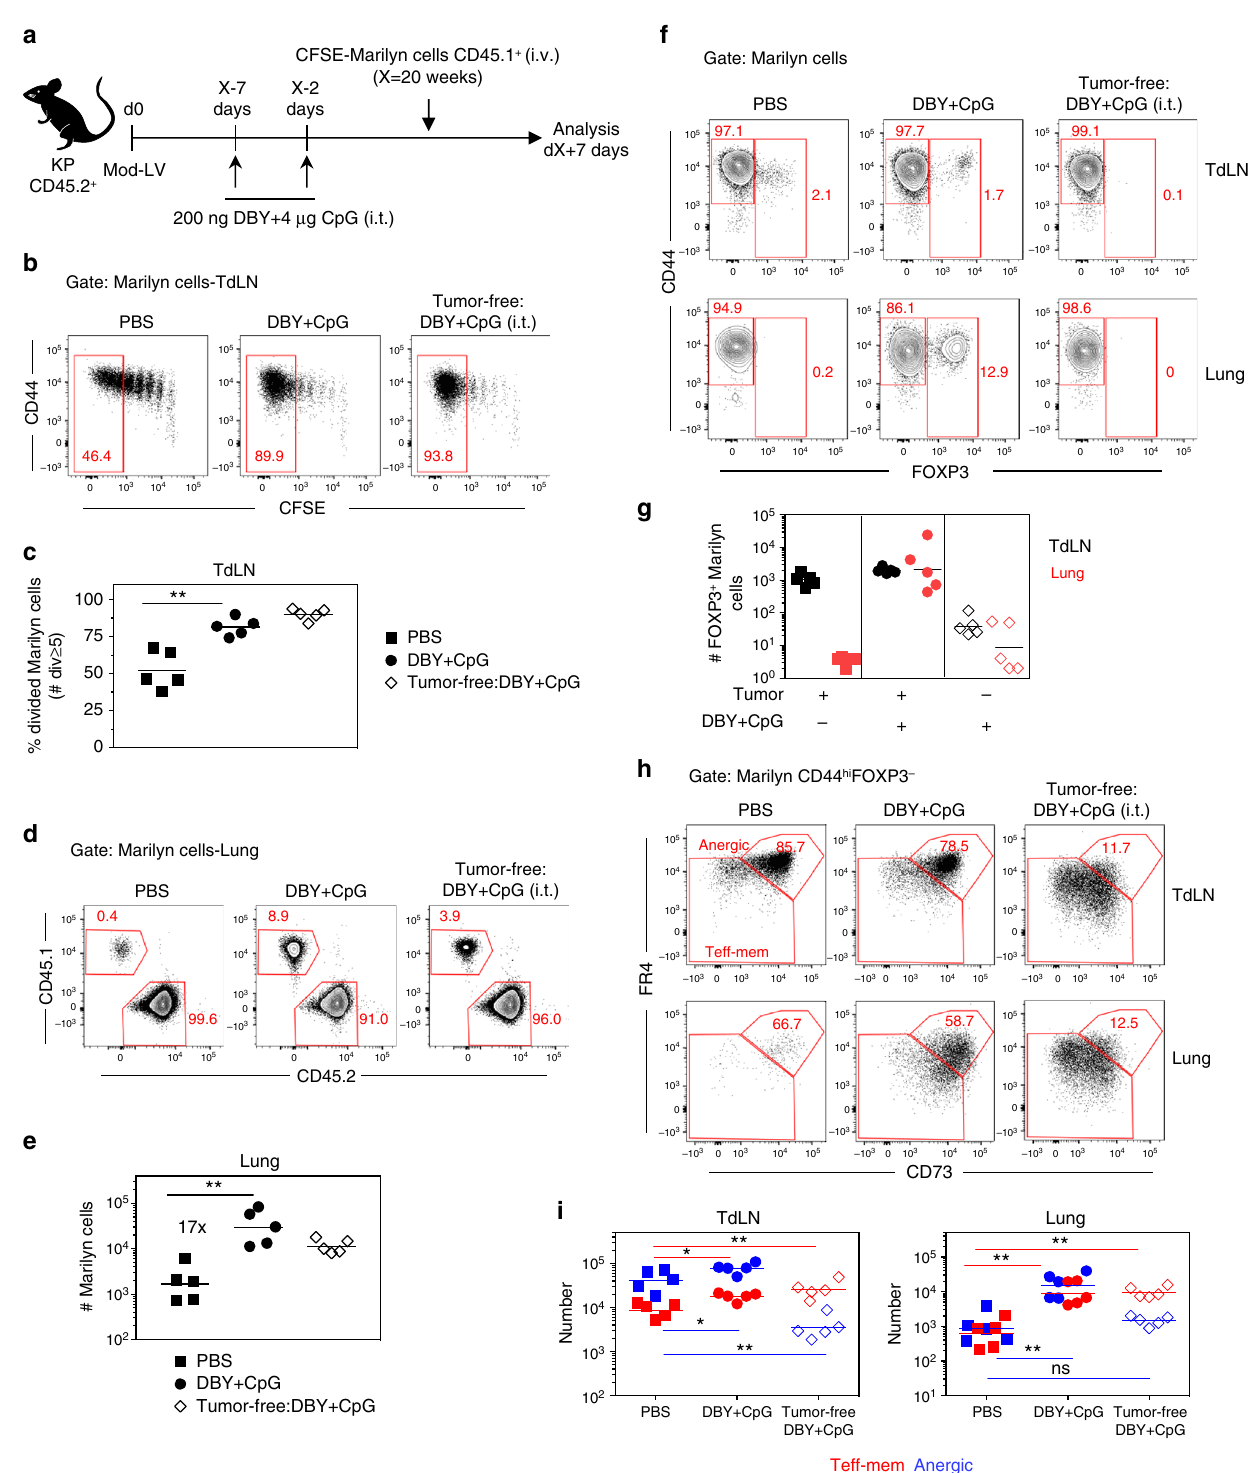
Fig. 6 Concomitant administration of DBY and CpG at the tumor site reinforces tumor-mediated immunosuppression. a Tumor-bearing mice were i.t. injected twice with DBY peptide (200 ng) and CpG (4 μ g) at 5-day interval followed 2 days after by CFSE-labeled naive Marilyn cell transfer. b Pattern of proliferation of Marilyn cells in the TdLN and c quanti fi cation (frequency of ≥ 5 divisions). d Representative plots showing the frequency of Marilyn cells in the lung and e quanti fi cation (number). f FOXP3 expression by Marilyn cells and g quanti fi cation (number). h Representative FR4 and CD73 expression on CD44 hi FOXP3 − Marilyn cells and i quanti fi cation (number of anergic or Teff-mem cells). ns: non-signi fi cant, * p <0.05, ** p <0.01 Mann – Whitney U